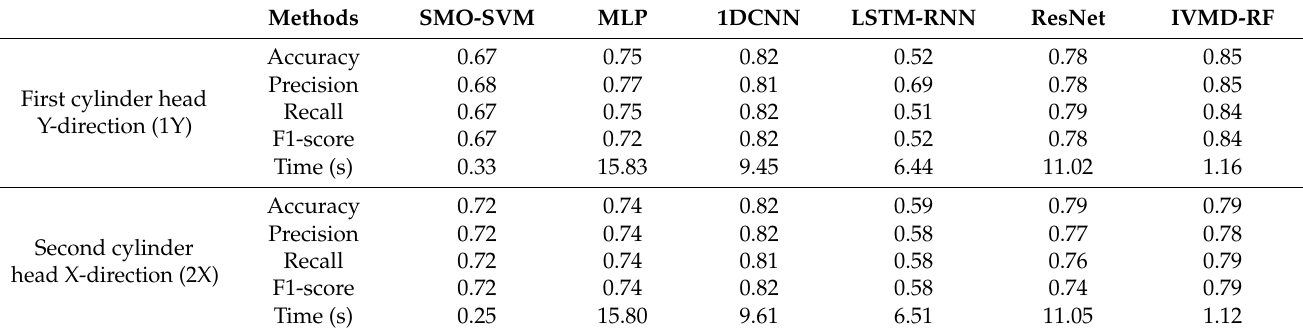
Table 11. Comparison of fault diagnosis results of each algorithm for gasoline engine